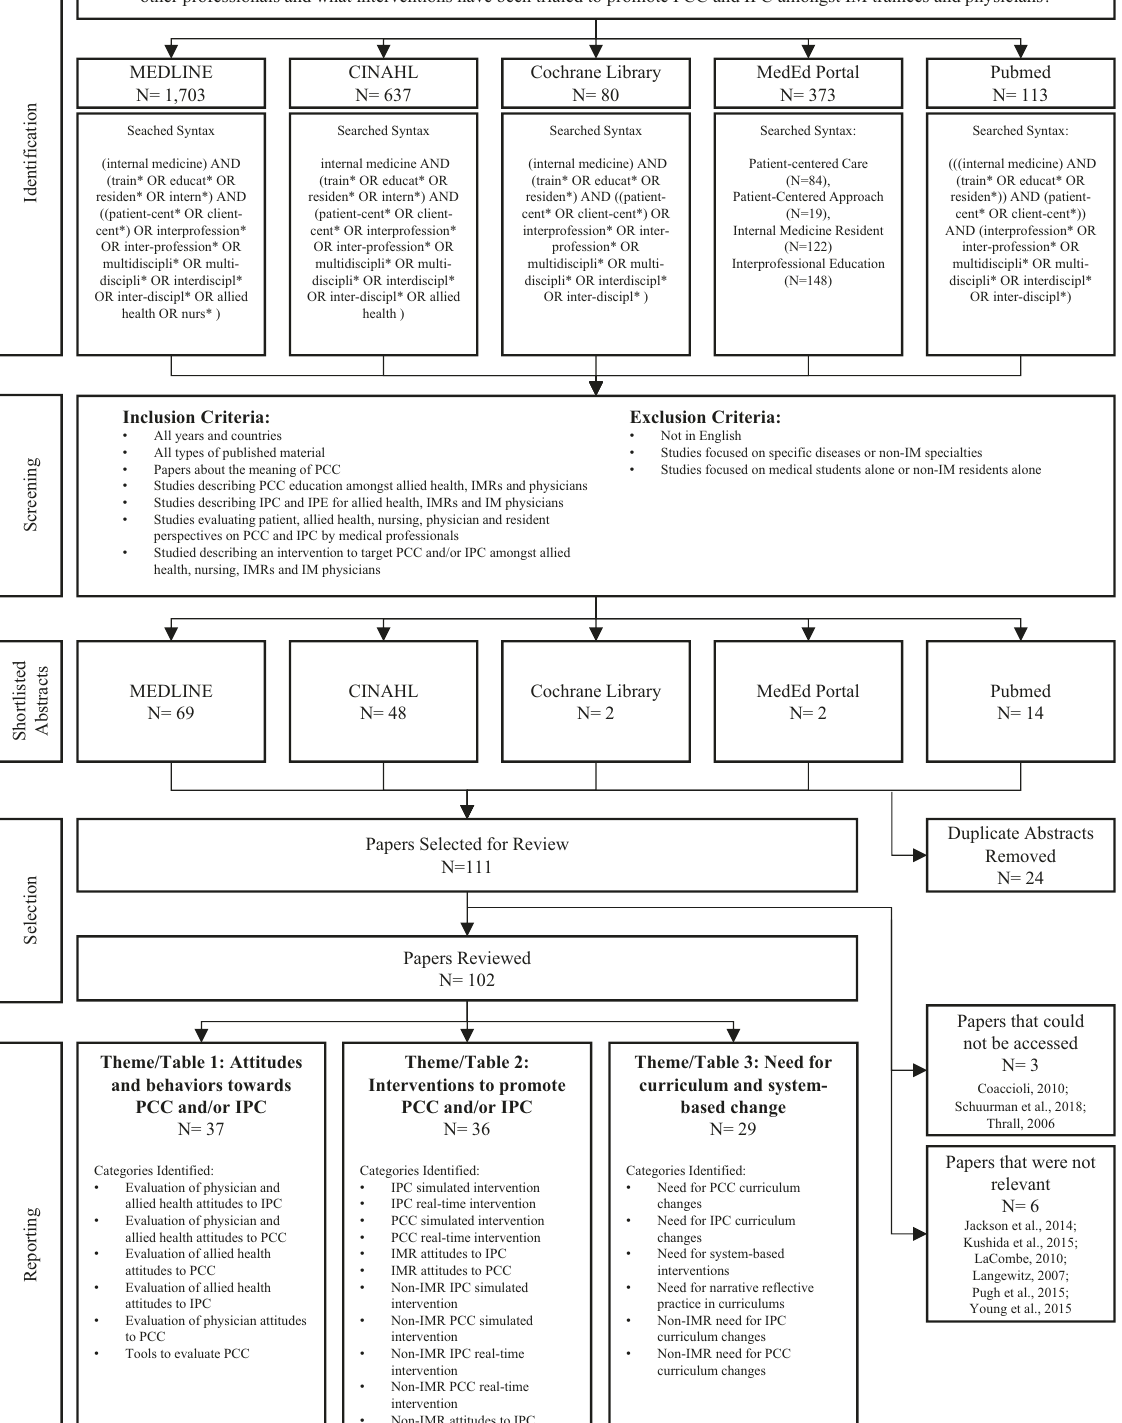
Theme/Table 2: Interventions to promote